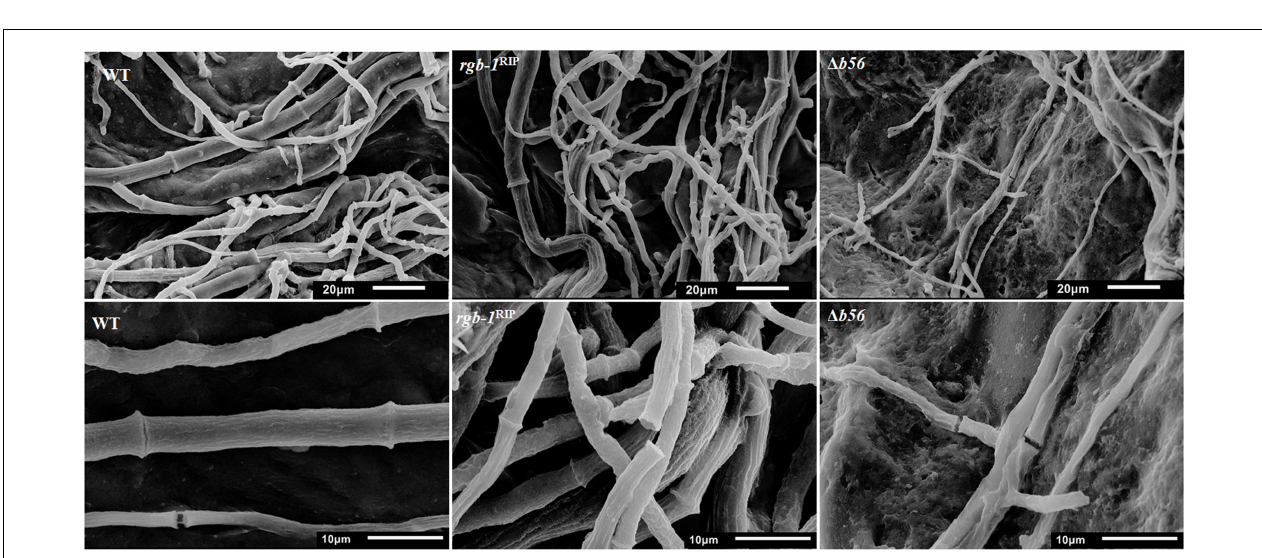
FIGURE 3 | Inactivation of the PP2A regulatory subunits rgb-1 and b56 affects fungal morphology. (A) Hyphal morphology at the edge of wt, rgb-1 RIP , and (cid:49) b56 colonies. Bar = 100 µ m. (B) Distance between branches of the wt, rgb-1 RIP , and (cid:49) b56 strains. Bars indicate standard error.